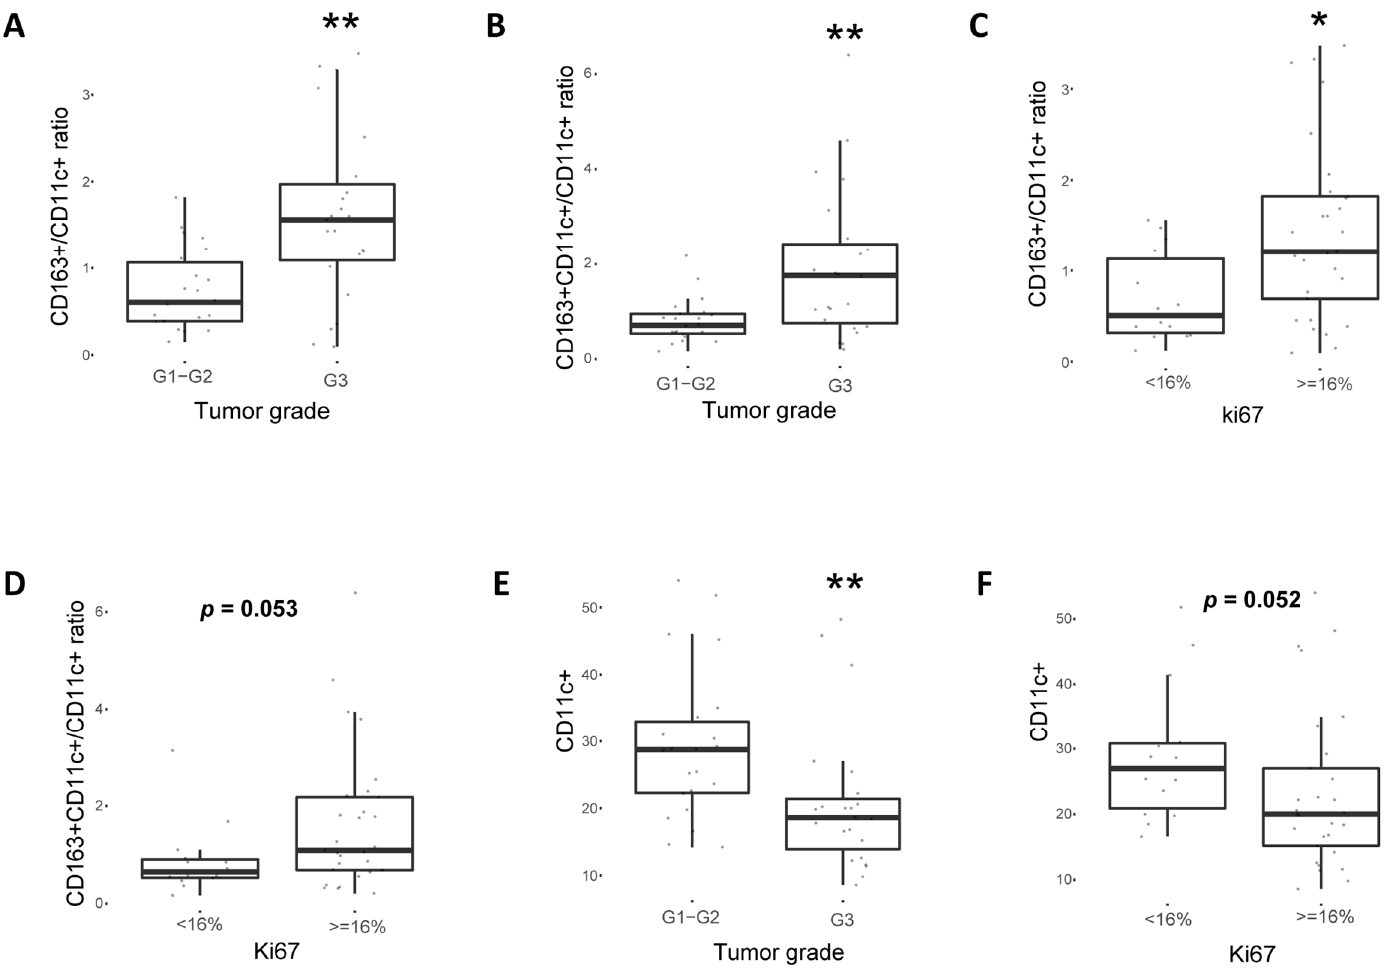
Figure 6. CD163 + macrophage phenotype correlates with higher Ki67 and grade in human breast cancer patients. CD163 + /CD11c + and CD163 + CD11c + /CD11c + ratios were positively correlated with high grade ( A,B ) and high Ki67 ( C,D ) in breast cancer patient patients ( n = 45). CD11c + cell expression was associated with lower tumor grade and lower Ki67 ( E,F ). Wilcoxon-Mann-Whitney test was used (* p < 0.05; ** p < 0.01; *** p < 0.001).